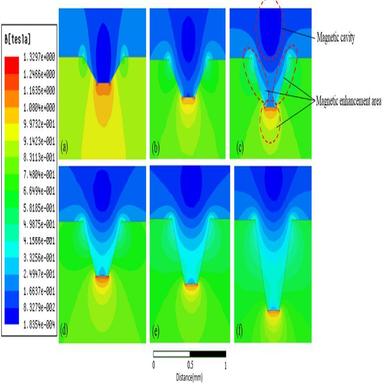
Simulation results of different trapezoid depths for HMM; (a) Trapezoid defect depths of 0.1 mm; (b) Trapezoid defect depths of 0.2 mm; (c) Trapezoid defect depths of 0.3 mm; (d) Trapezoid defect depths of 0.4 mm; (e) Trapezoid defect depths of 0.5 mm; (f) Trapezoid defect depths of 0.6 mm.